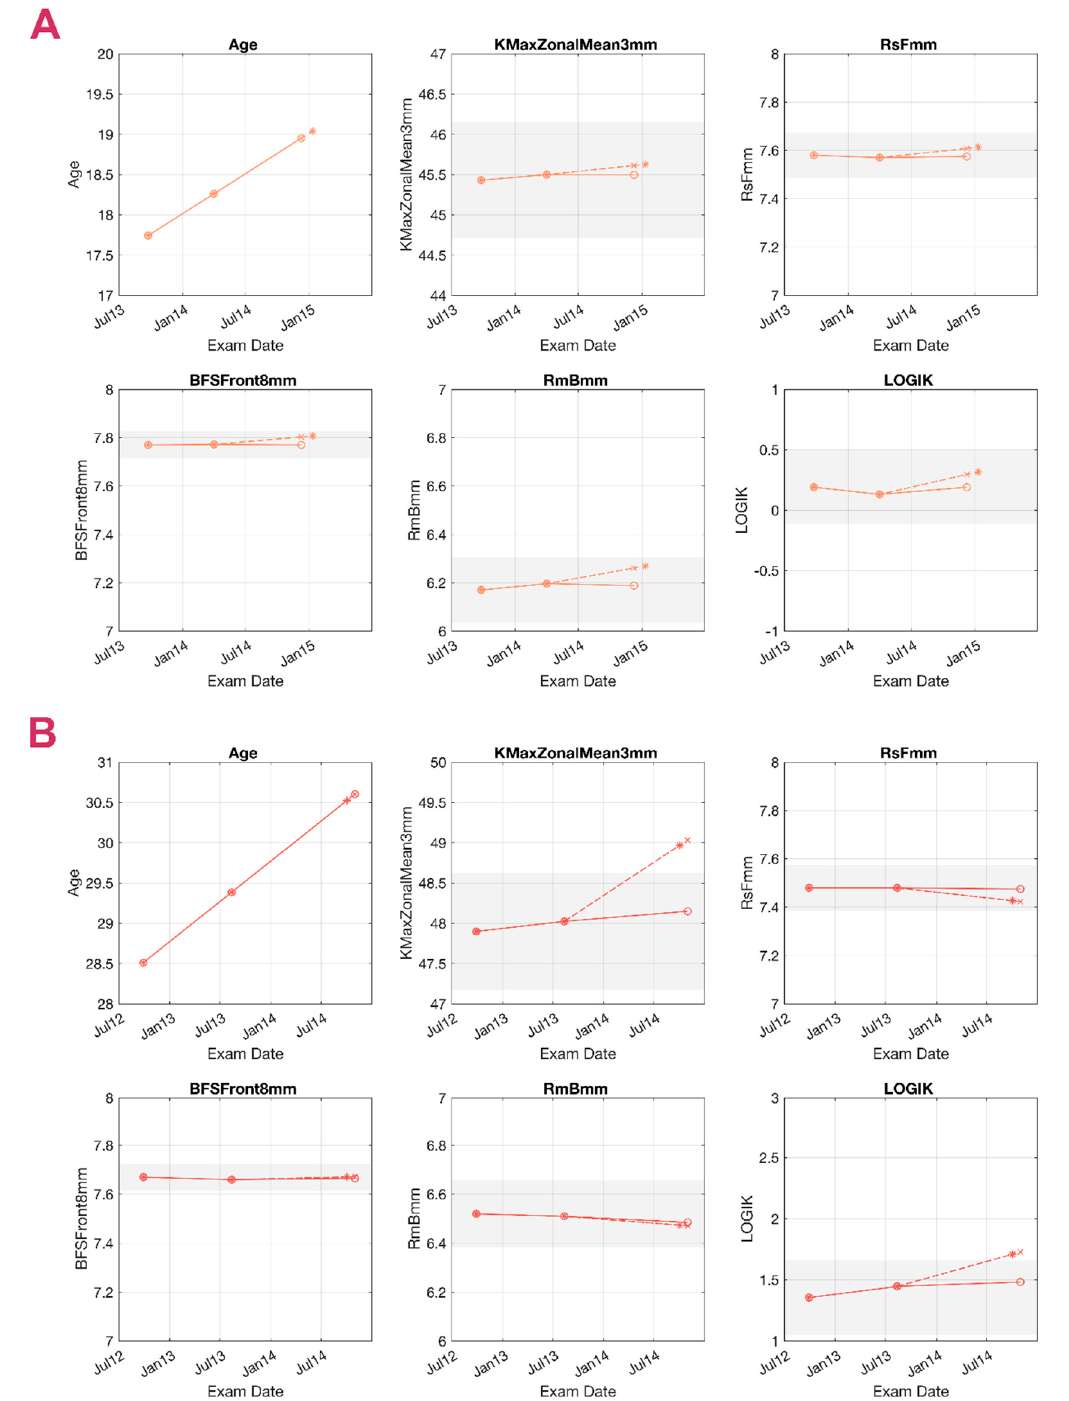
Figure 6. Prediction of a true-negative (TN) and a false-positive (FP) case. Grey areas represent the 95% confidence interval (95 CI) around the baseline value. Circles (o) represent the measured values in 3 consecutive exams, and the asterisk ( ∗ ) represents the predicted output. The cross ( × ) is calculated by linear interpolation and aligned to the 2nd follow-up. Continuous lines represent the measured trend, and the dashed lines represent the predicted trend. Measurements within the 95 CI are presented with the noise reduction applied. ( A ) TN, 17 years old. The system predicted stability, so there was no significant change, which coincided with the real measurements. ( B ) FP, 28 years old. The system predicted a significant change in the average keratometry in a 3 mm area around the maximum curvature point (KmaxZonalMean3mm) and LOGIK, but the measured values remained stable within the 95 CI. BFSF: best fit sphere of the front surface considering an 8 mm area, RmB: average radius of the back surface in mm, RsF: steepest radius of the front surface in mm.